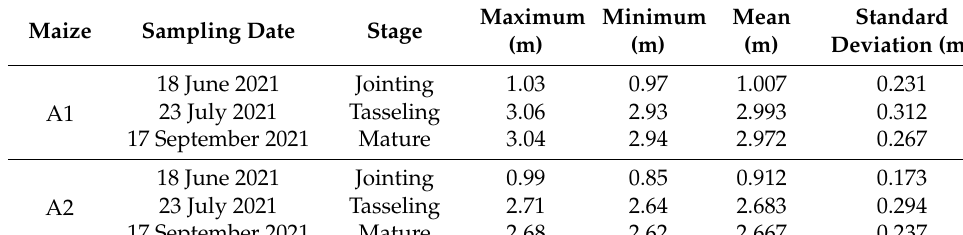
Table 3. Statistics of field measurements per maize at three growth stages.